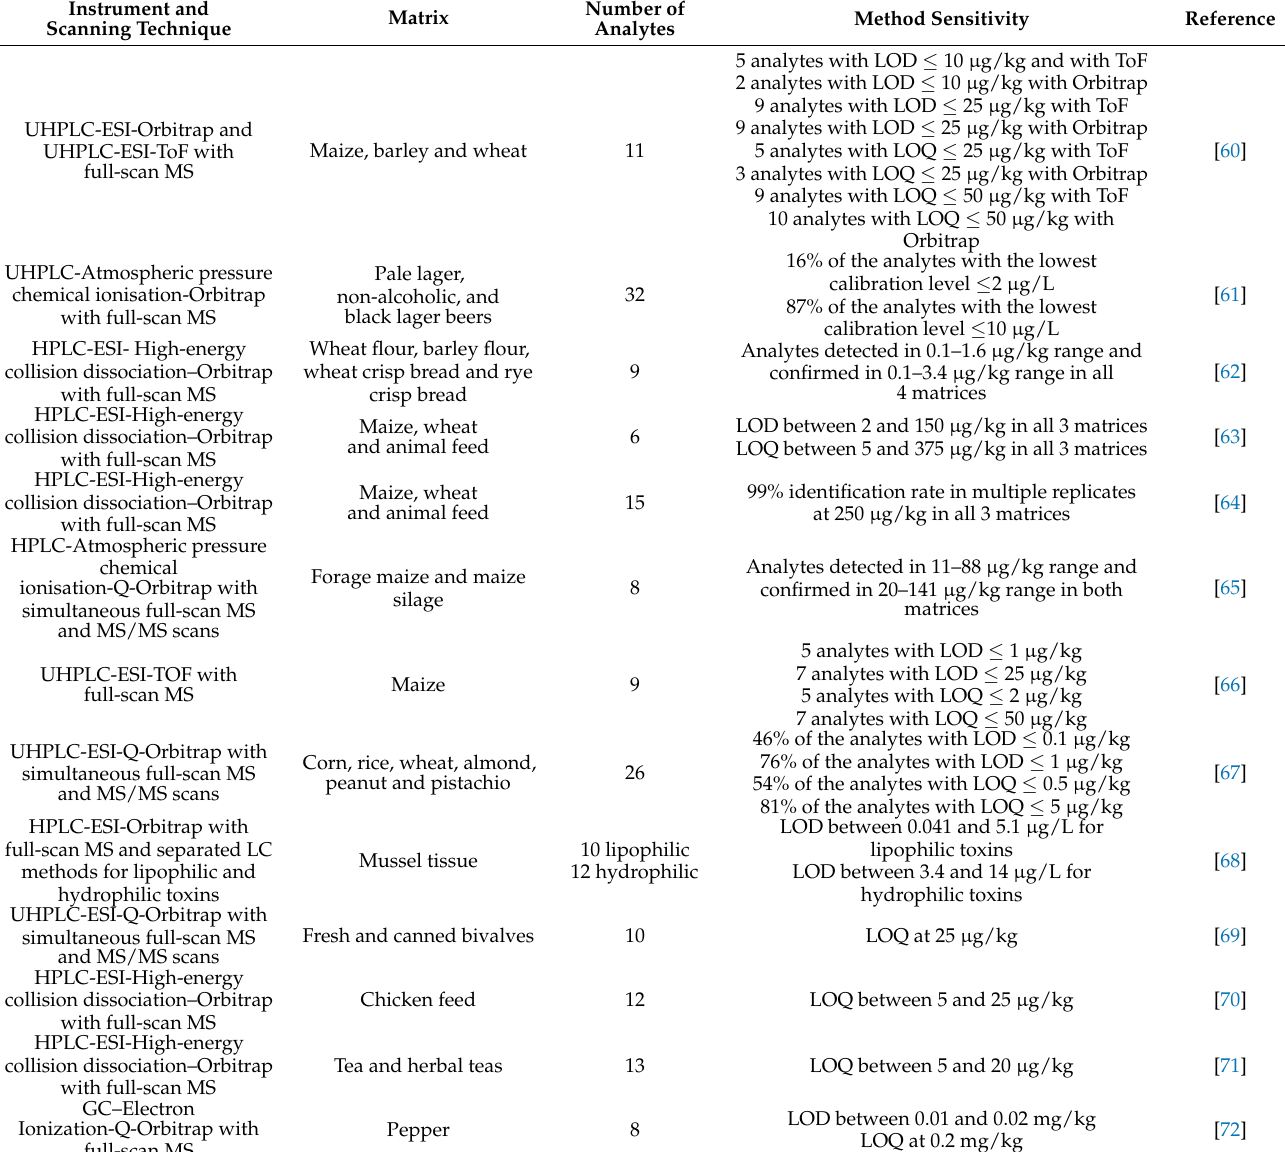
Table 3. Selected studies on natural toxins analysis by